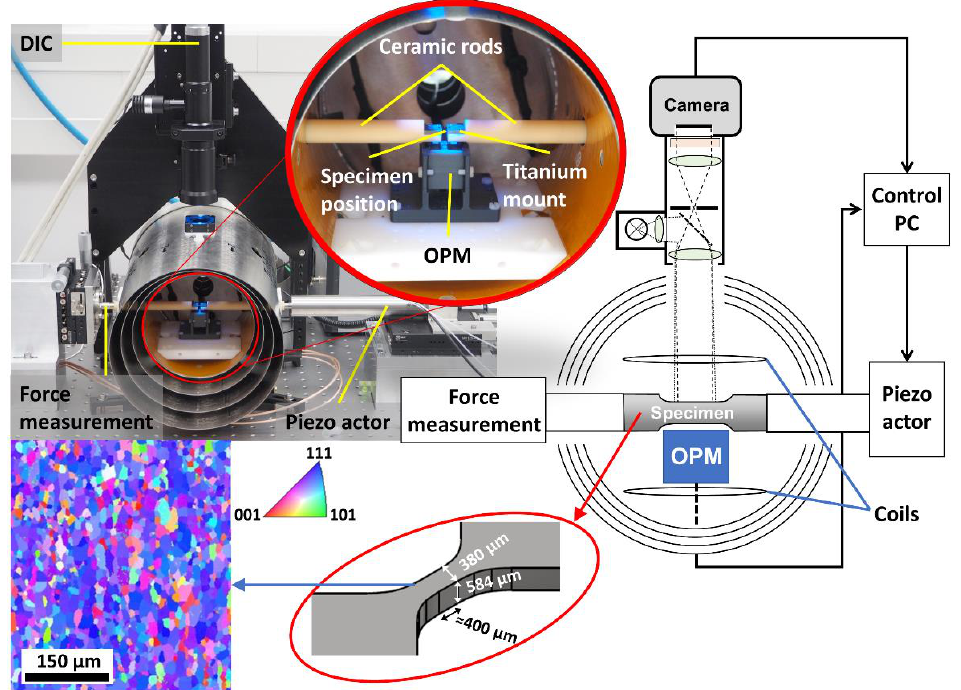
Figure 1. Experimental (micro-magneto-mechanical) setup used in this work. On the left, a picture of the setup with the main components is shown. The specimen under test (SUT) is placed inside of a mu-metal shield and kept in position by means of ceramic rods and titanium mounts. The OPM, which measures the field emanating from the specimen, is placed right below the specimen. A digital image correlation (DIC) sensor is positioned outside of the shield and serves as a non-contact optical detector of the deformations of the SUT. On the right, a schematic representation of the same setup is drawn. It shows more details on the image formation of the DIC. A system of coils inside of the mu-metal shield allows adaption of the magnetic environment to the specific operating conditions of the OPM. The detailed specimen view shows the dimensions of the SUT gauge. To the left of it, an electron backscatter diffraction image of a cross-section of this ferritic steel conveys an impression of the texture, which features grain sizes of 10 – 15 µm.